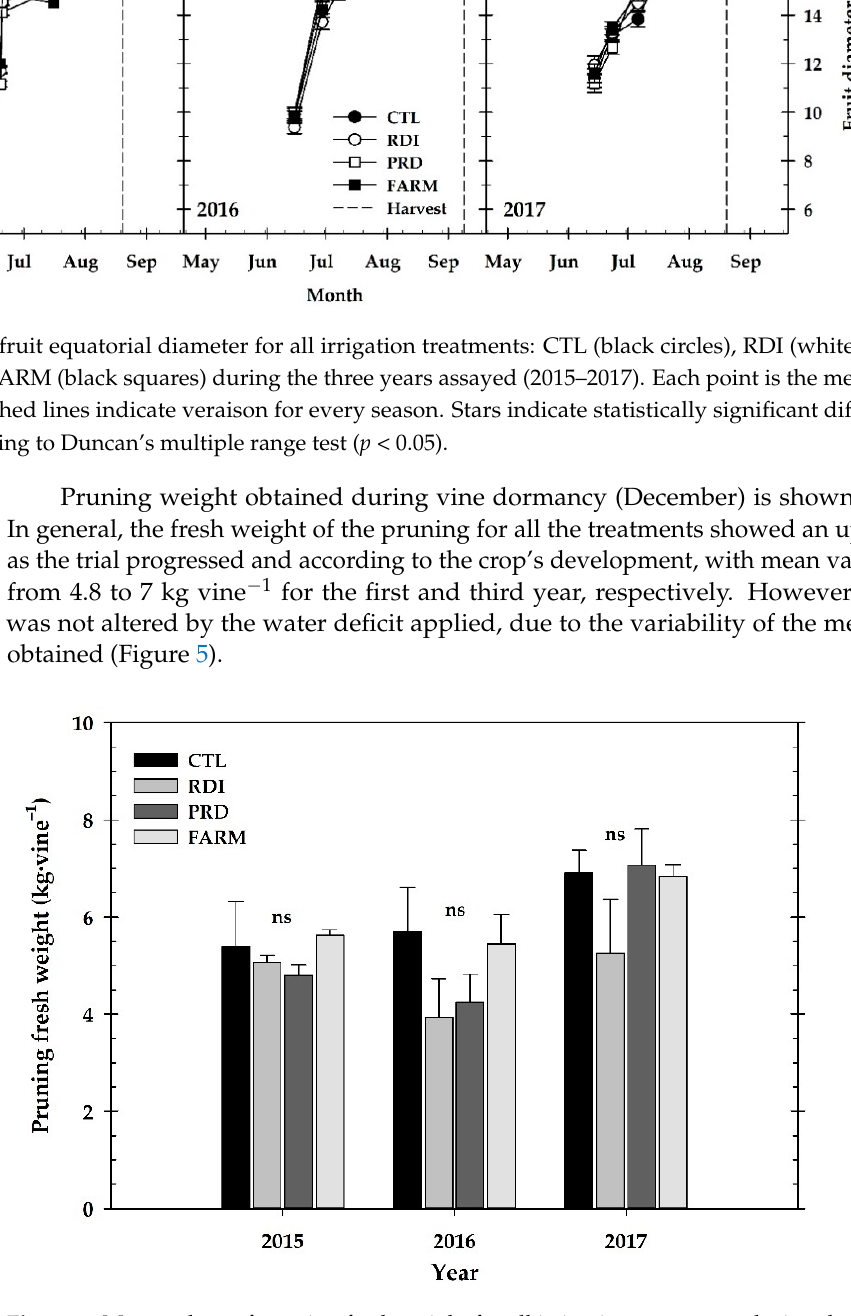
Figure 5. Mean values of pruning fresh weight for all irrigation treatments during the experimental period (2015, 2016 and 2017). Vertical bars indicate the standard error ( n = 18). Columns with different letters denote significant differences according to Duncan’s multiple range test ( p <